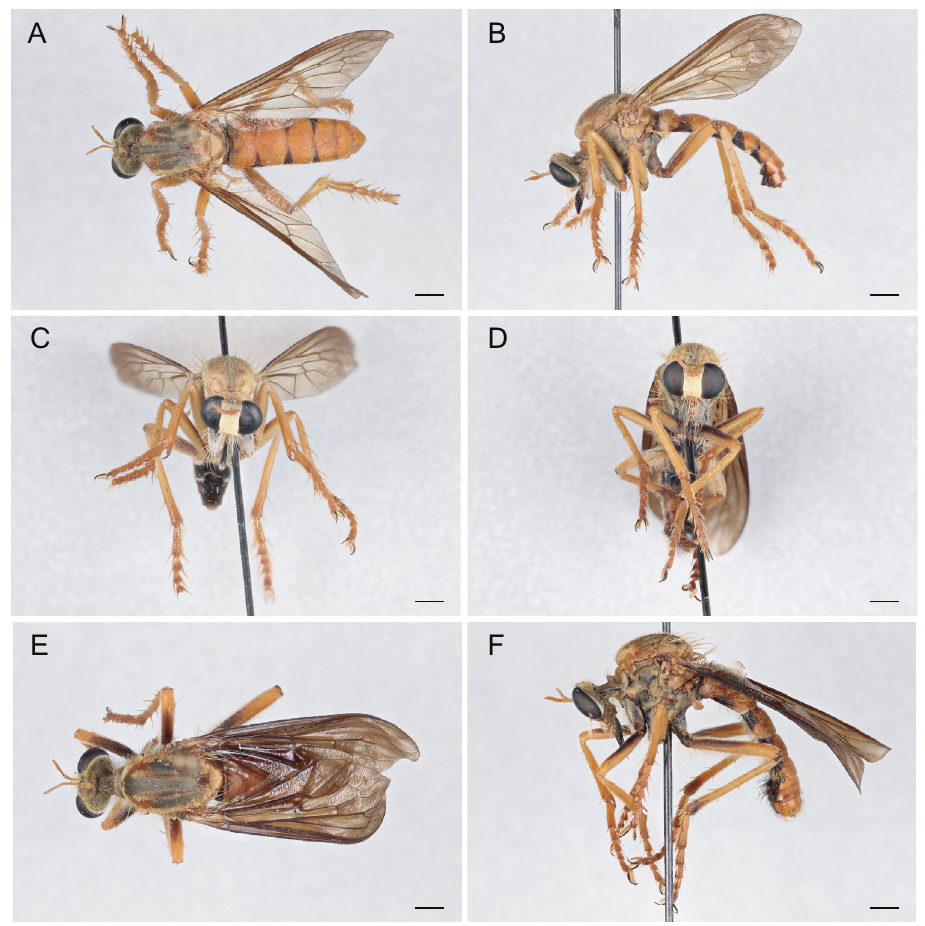
Figure 9. Saropogon bryanti Wilcox, 1966 Female (USNMENT01830074): A dorsal view B lateral view C anterior view; Male (USNMENT01830073): D anterior view E dorsal view F lateral view. Scale bars: 2